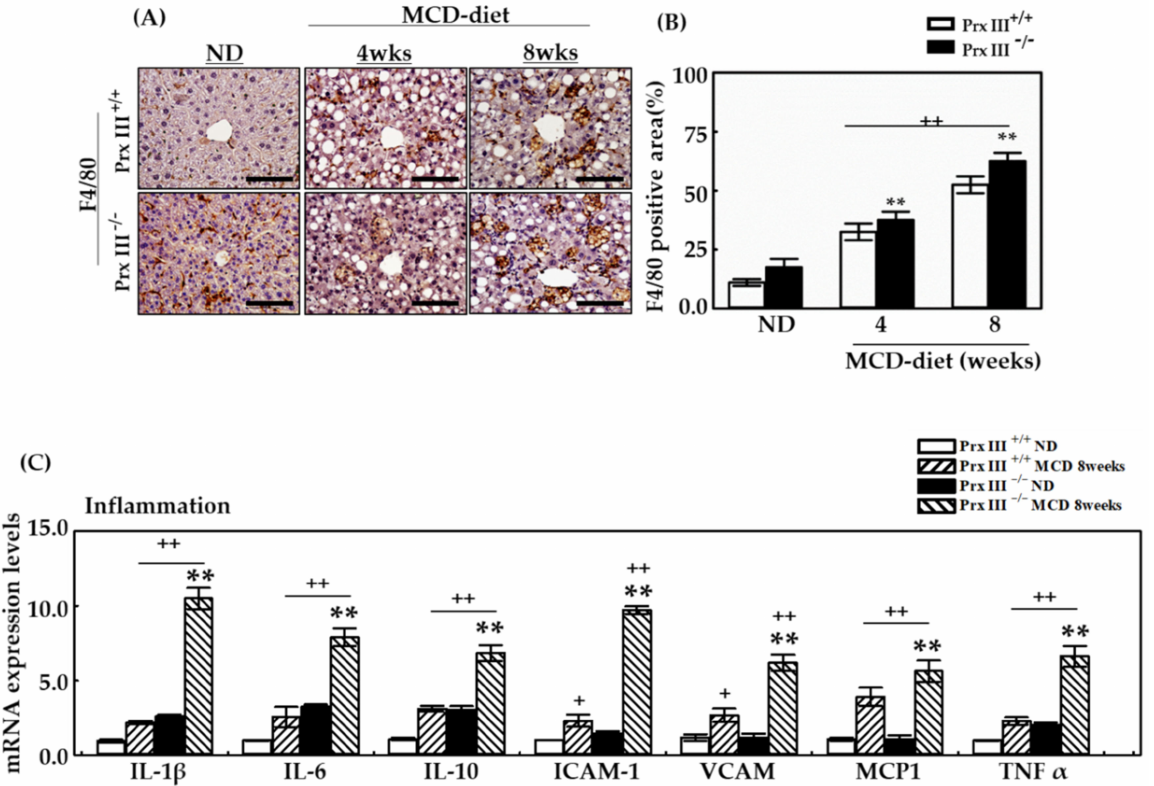
Figure 5. Effects of Prx III deficiency on hepatic inflammation through F4/80 staining and mRNA expression levels associated with liver inflammation in MCD diet. Prx III +/+ and -/- mice were fed the ND or MCD diet for 4 and 8 weeks. Mice were sacrificed at 4 and 8 weeks. The liver from each mouse was fixed with 4% formaldehyde in phosphate-buffered saline at 4 ◦ C overnight and embedded in paraffin. The liver sections (4 µ m thick) were stained for F4/80 as a major macrophage infiltration marker. ( A , B ) F4/80 staining in liver tissues from Prx III +/+ and Prx -/- mice fed the ND or MCD diet for 4 and 8 weeks was quantified by NIS-Elements AR 3.1 software. The scale bars indicate 100 µ m at original magnifications of 400 × . Real-time PCR was performed to assess mRNA levels of liver inflammation-related genes in the ND and MCD diet groups at 8 weeks. mRNA from the liver using TRIzol reagent was subjected to RT-PCR and quantitative PCR. Expression levels of mRNA were normalized to that of GAPDH mRNA. ( C ) The mRNA expression levels of liver inflammation-related genes in Prx III +/+ and -/- mice fed the ND or MCD diet for 8 weeks. Data are means ± SE from three independent experiments, with four to six mice per group. + p < 0.05, ++ p < 0.01 vs. control group mice fed ND, ** p < 0.01 vs. the MCD diet-fed Prx III +/+